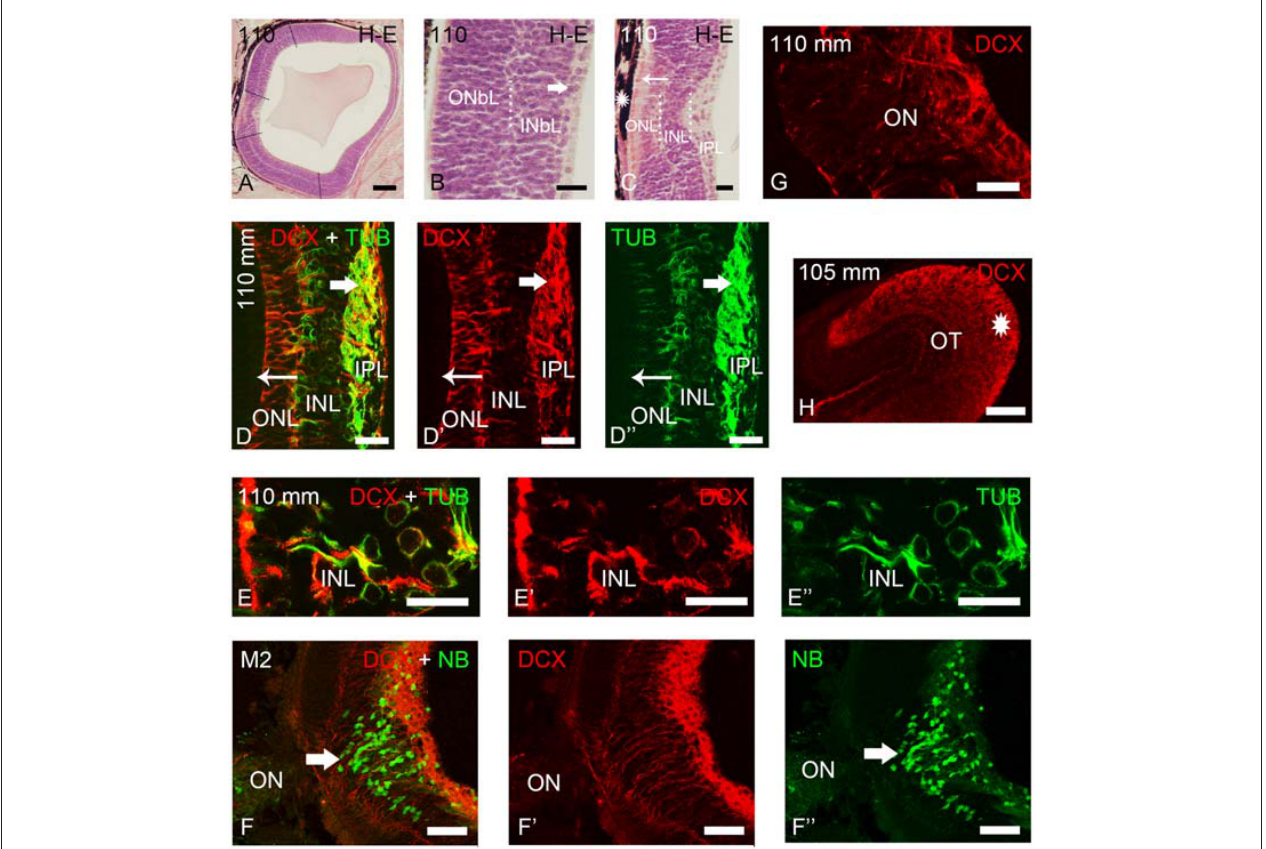
FIGURE 3 | Photomicrographs of transverse sections of retina and the optic tectum of premetamorphic and metamorphic larval lampreys stained with H-E (A–C) or immunostained for DCX, TUB and/or NB (D–H). (A) Low magnification photomicrograph showing the central and lateral neural retina. Note that the lateral retina extends through most of the retina excepting the central region and a thin irideal retina. Dash lines mark the limit between the central and lateral retinas and between the central and peripheral portions of the lateral retina. (B) Detail of the central portion of the lateral retina showing distinguishable inner (INbL) and outer (ONbL) neuroblastic layers. A thin inner region with differentiated ganglion cells is also observed (thick arrow). (C) Detail of the central retina. The thin arrow points to photoreceptors. The asterisk indicates the dorsal retinal pigment epithelium bearing melanin granules. Dotted lines mark the limits between layers in the lateral retina in (B) and in the central retina in (C) . (D–D”) Double immunolabeling for DCX and α -tubulin in the central retina. Note the absence of DCX immunoreactivity in photoreceptors (thin arrow) and its presence in ganglion cells (thick arrow) and in cells of the INL. Note also the DCX/ α -tubulin-ir double-labeled radial fibers coursing in the INL and ONL and DCX-ir/ α -tubulin-negative end feet in the outer limitans membrane (OLM). (E–E”) Detail of the INL of the central retina of a premetamorphic larva showing the presence of DCX/ α -tubulin-ir double-labeled cells. (F–F”) Absence of DCX immunoreactivity in the ganglion cells labeled after application of neurobiotin in the ON of a metamorphic larva (M2). (G) Detail showing DCX-ir fibers in the ON. (H) DCX-ir optic fibers in the optic tectum (asterisk). In all photomicrographs dorsal is up and medial is to the left. (D–F) : Overlay; (D’–F’) : DCX; (D”,E”) : α -tubulin; (F”) : NB. Scale bars = 75 µ m in (F–F”) ; 60 µ m (A) ; 50 µ m (H) ; 25 µ m (D–E”,G) ; 10 µ m (B,C)